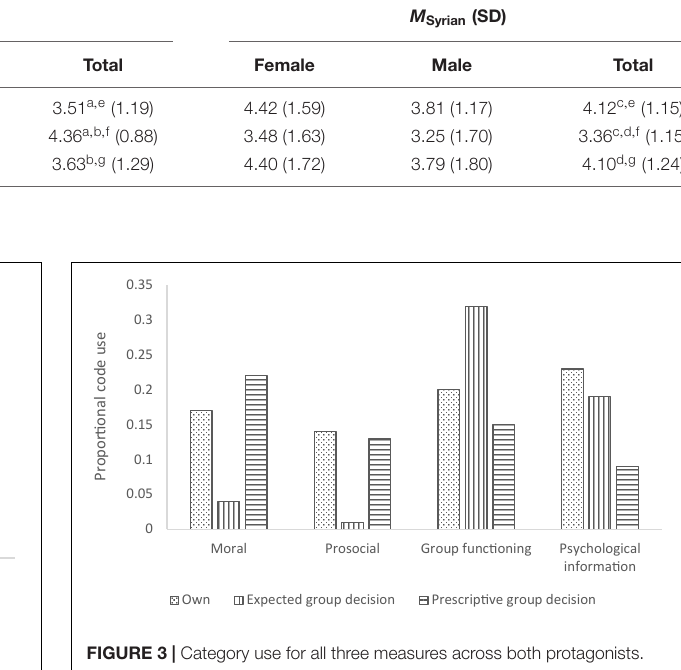
TABLE 2 | Means and Standard Deviations of all three measures for each protagonist. Measure M German (SD)